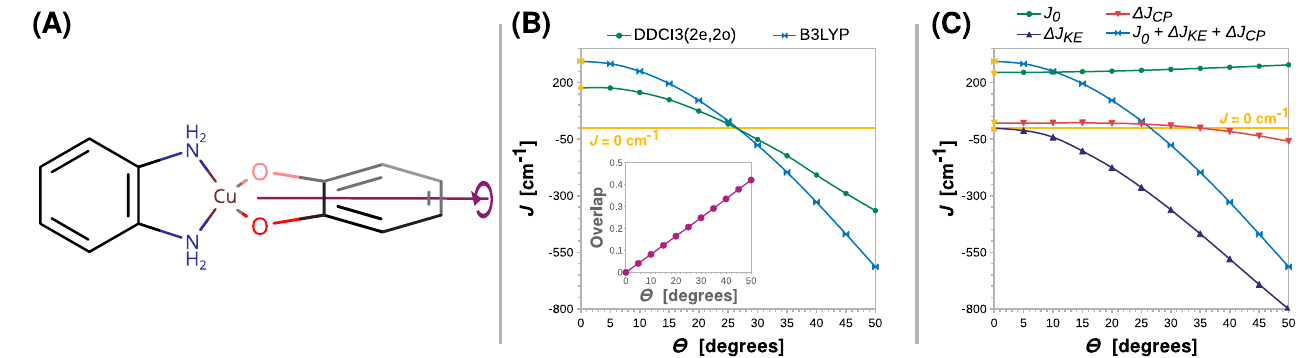
Figure 7. Rigid scan of J along the twisting angle between the N-Cu-N and O-Cu-O planes ( Θ ): schematic representation of the varied structural parameter ( A ); the parameter J predicted at the B3LYP and DDCI3(2e,2o) levels ( B ); decomposition of J at the B3LYP level ( C ). Inset in ( B ) shows the overlap of the magnetic orbitals calculated at the B3LYP level. All are calculated with the def2-TZVP basis set. For clarity, the line J = 0 cm − 1 is shown as a reference. For the geometry optimized at the B3LYP/def2-TZVP theory level Θ = 0° (labeled with the yellow symbols).